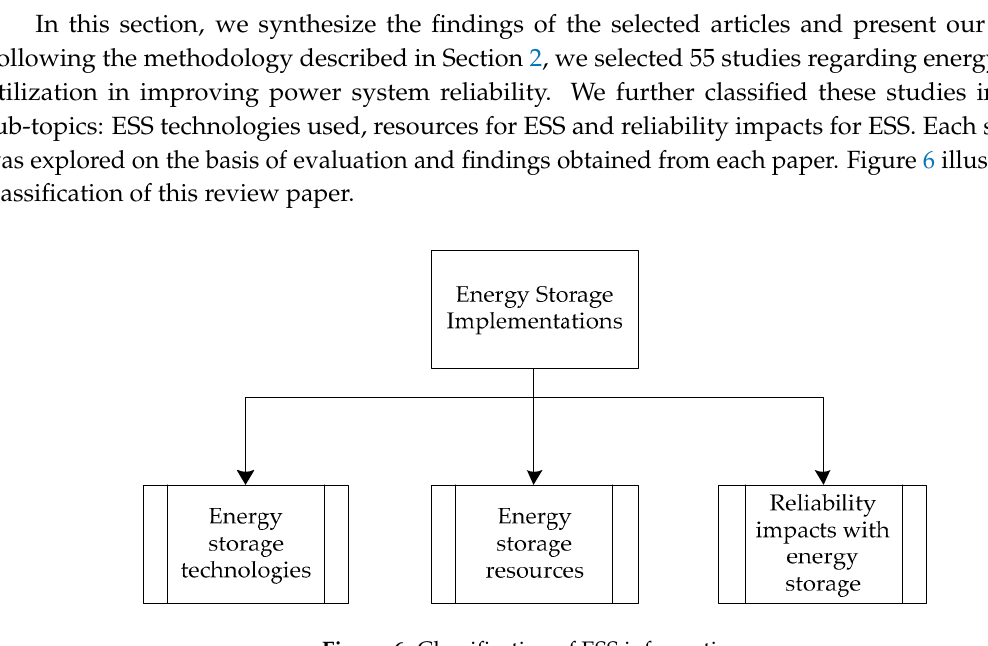
Figure 6. Classification of ESS information.